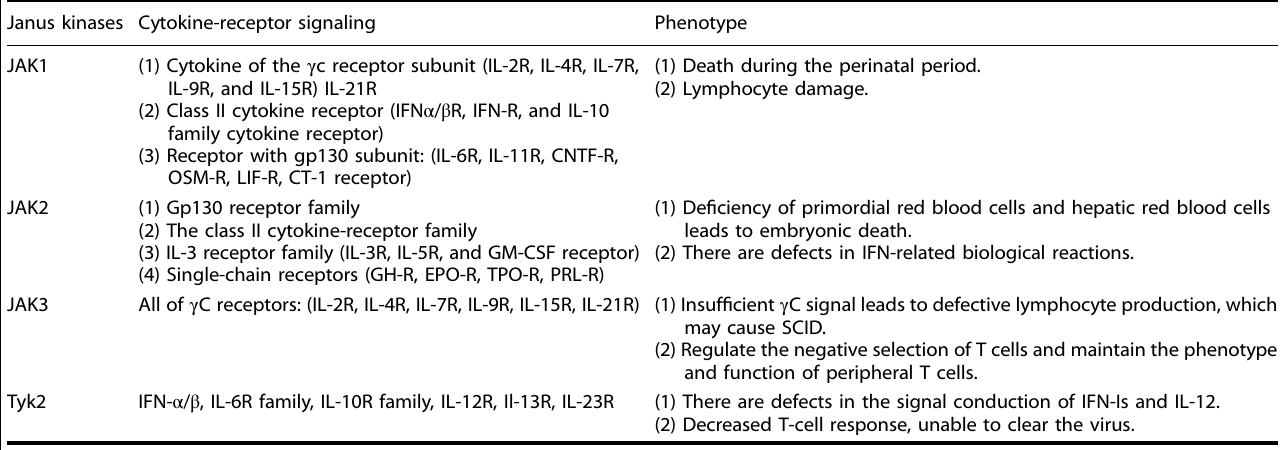
Table 1. Activated JAK family-related cytokine receptors and JAK − / − mouse phenotype Janus kinases Cytokine-receptor